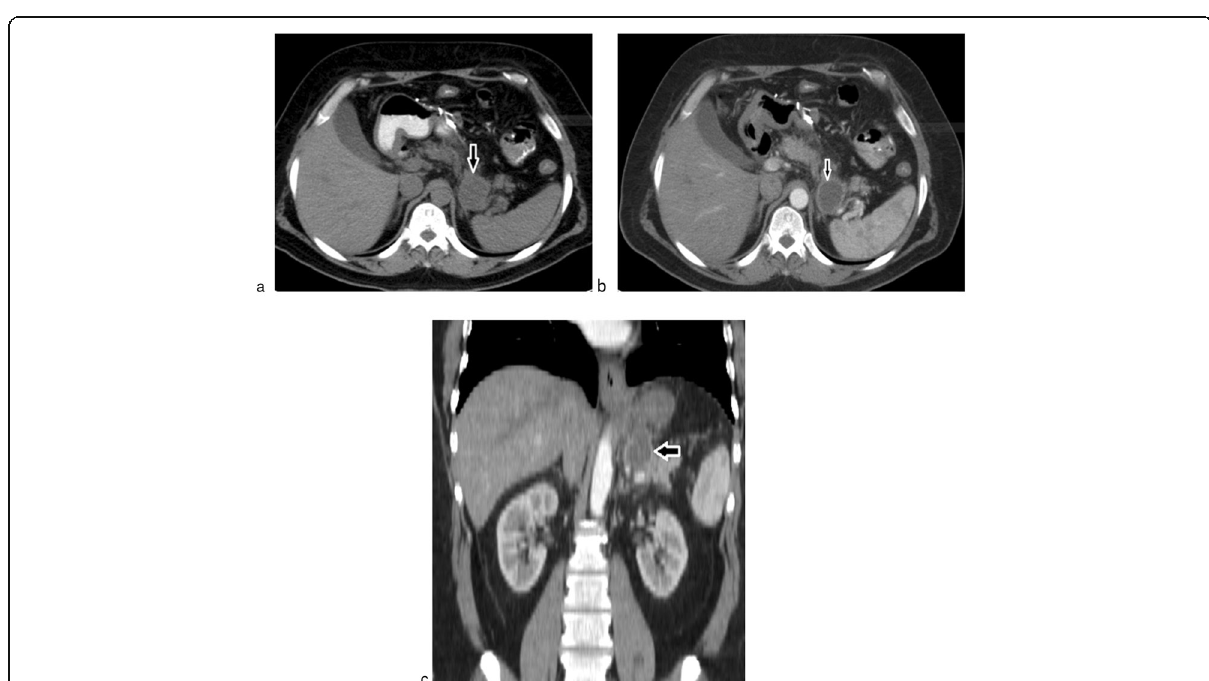
Fig. 8 A forty-three-year-old male patient presented 5 days post-lap. sleeve gastrectomy by severe abdominal pain, fever, and tachycardia. a , b MSCT axial and c coronal reformatted images show a localized collection on the left of the sleeved stomach, adherent to the tail of the pancreas with no obvious clear cleavage plane between them. This collection is associated with surrounding minimal focal mesenteric fat stranding and mural enhancement post-I.V. contrast administration. UGSI shows no abnormality. MSCT diagnosis: peri-gastro-pancreatic